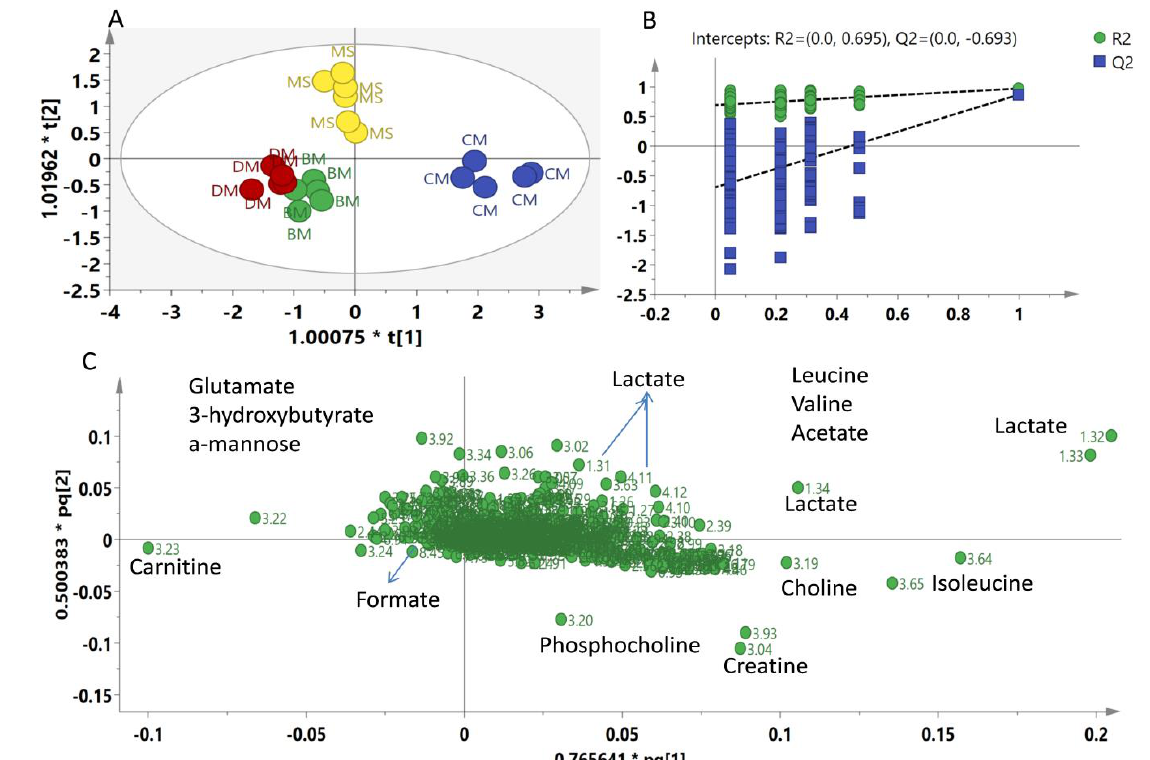
Figure 3. ( A ) Score plot (PLS1 vs. PLS2) of OPLS-DA based on whole range of1 1 H-NMR signals ( δ 0.5– δ 10.0) of CM = Chicken; MS = Chevon; BM = Beef; DM = Donkey. ( B ) Validation through 200 permutation test, ( C ) OPLS-DA Loading scatter plot.